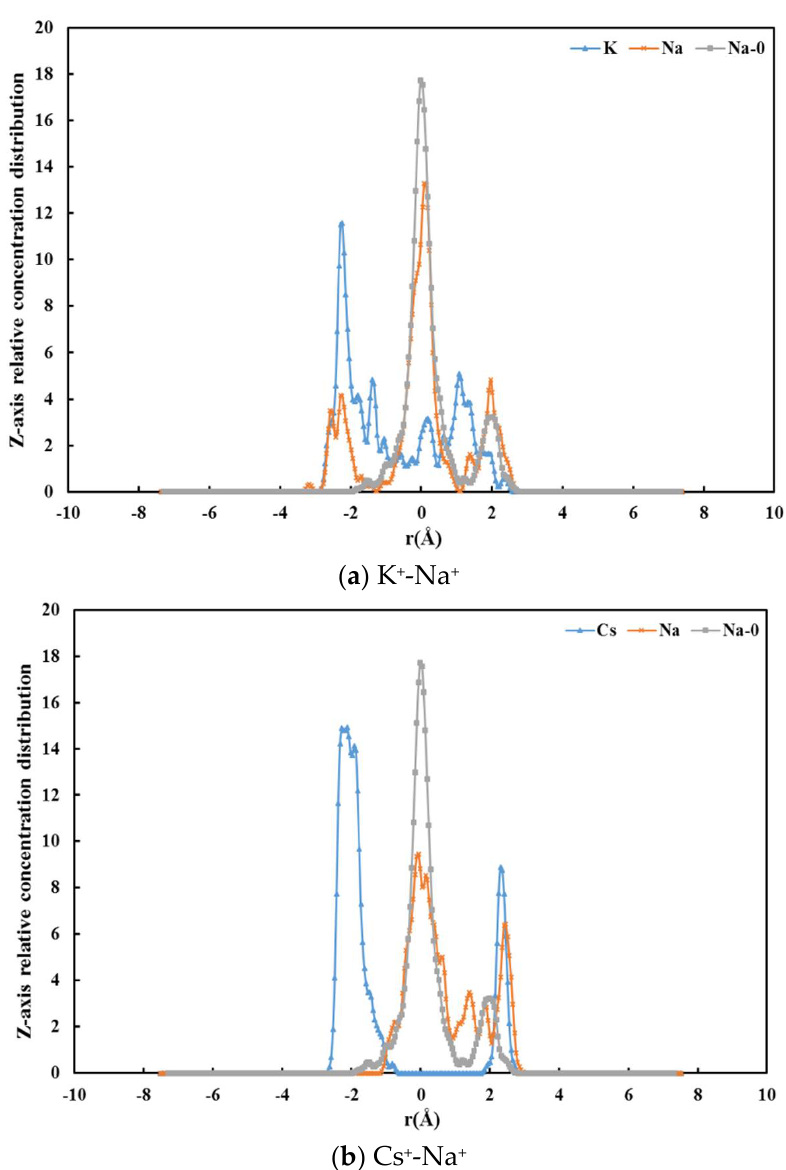
Figure 7. Z-axis relative concentration distribution of counterions.